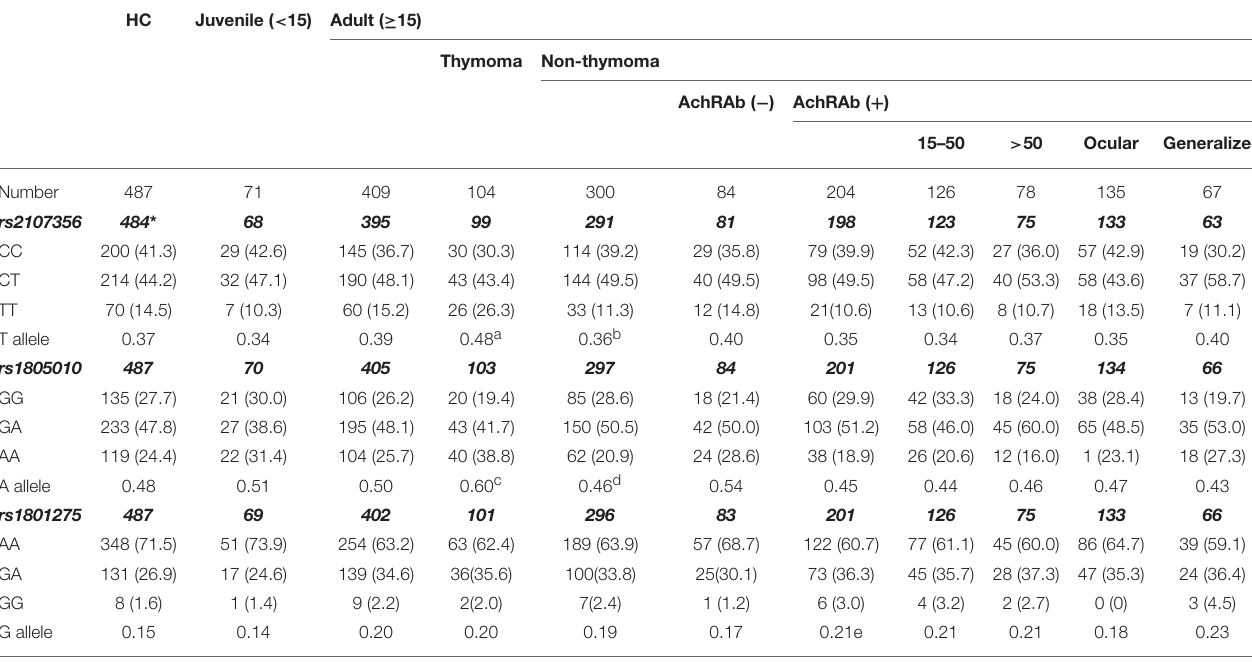
TABLE 6 | Frequencies of alleles and genotypes of rs1805010, rs1801275, and rs2107356 in MG subgroups of a new classification and the control group [case